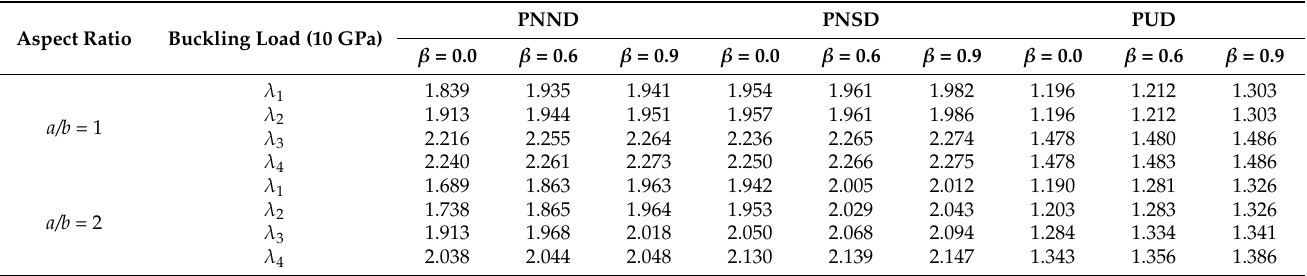
Table 7. First four shear buckling loads for a SSSS FG-saturated porous plate with different aspect ratios, a / b , porosity distributions and Skempton coefficients, β , while keeping e 0 = 0.6